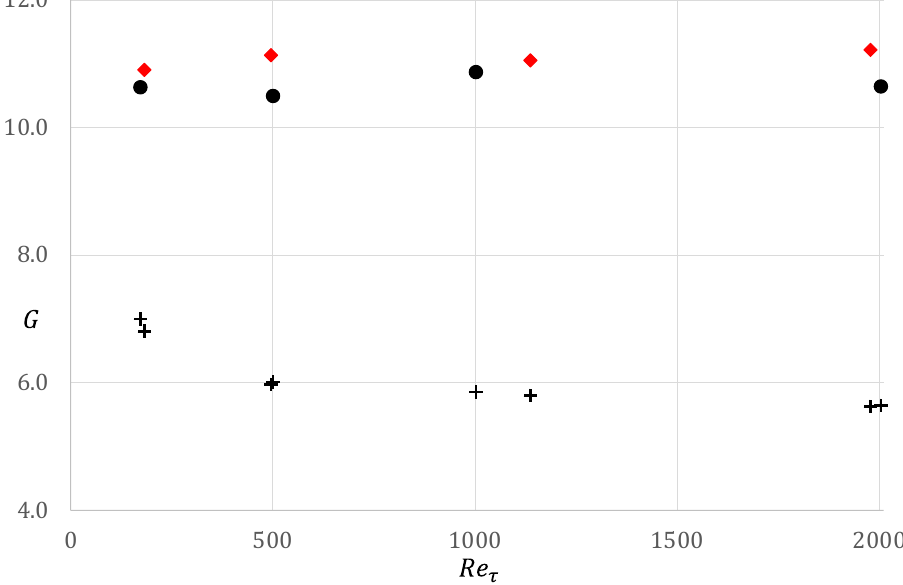
Figure 17. Trend of the second shape factor G ; • pipe DNS data [26]; (cid:7) pipe DNS data [31,32]; and + channel ITM.